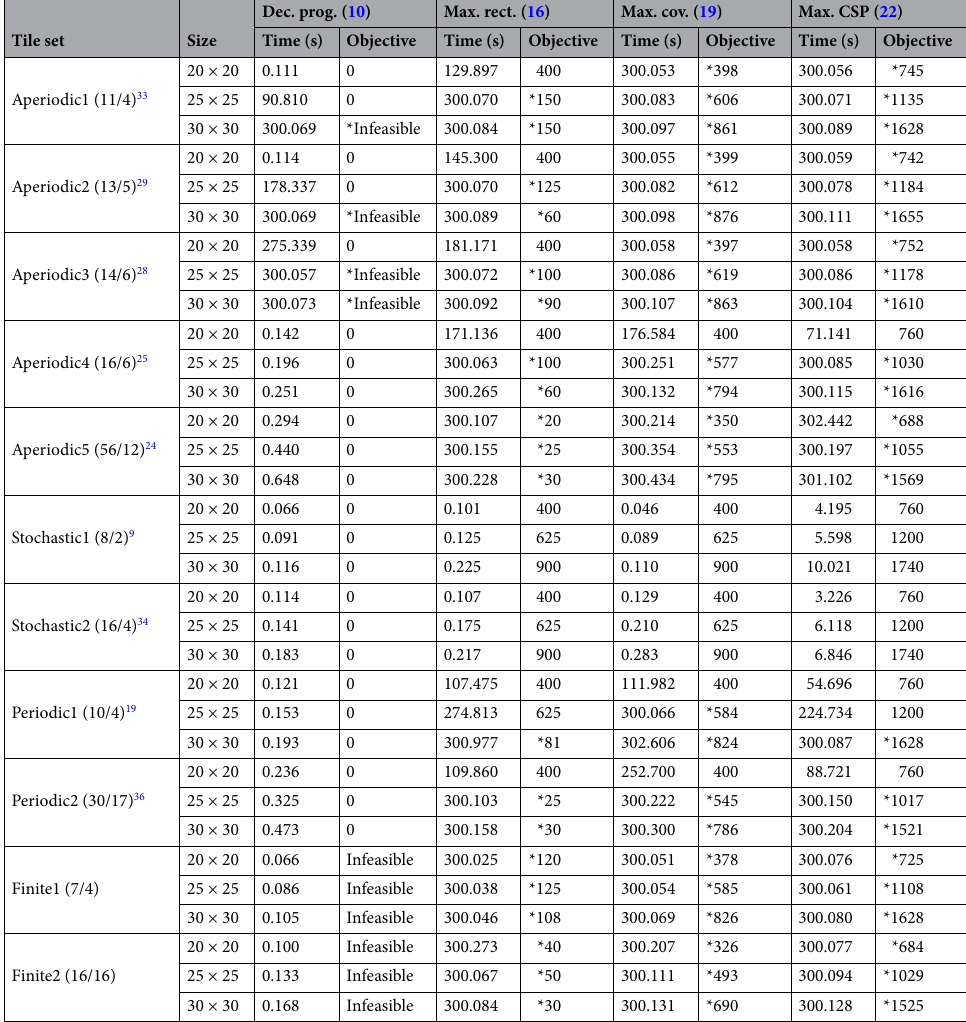
Table 1. Benchmark results. Values marked by an asterisk denote a premature termination of the integer programming solver. The objective function values are equal to the best feasible lower bounds for the individual formulations found by the optimization algorithm. In these formulations, the objective function values denote feasibility, rectangular area, covered area and the number of satisfied adjacency constraints,